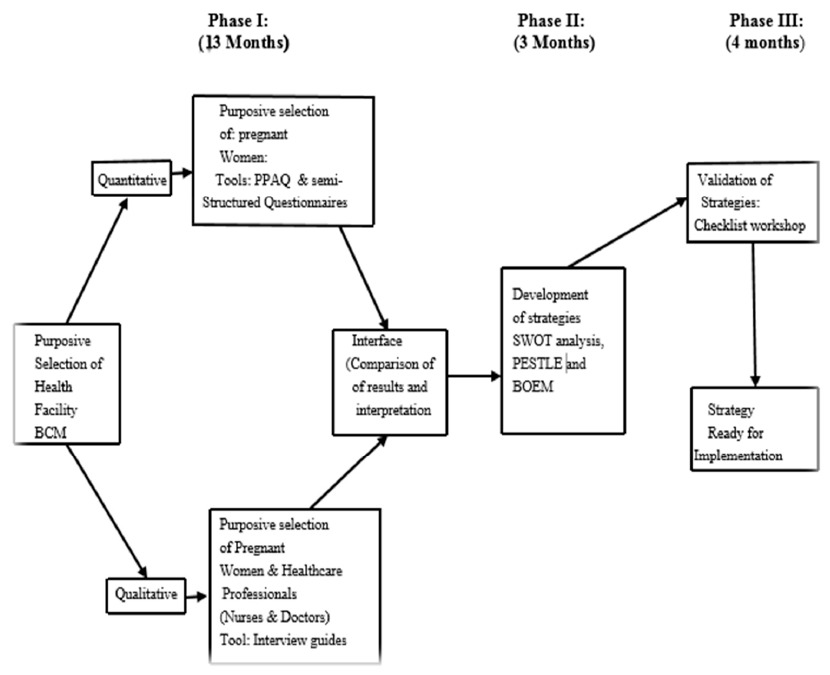
Figure 1. Research approach. BCM = Buffalo City Municipality; PPAQ = Pregnancy Physical Activity Questionnaire; SWOT = Strengths, Weaknesses, Opportunities and Threats; PESTLE = Political, Economic Growth, Socio-Cultural, Technological, Laws and Environmental; BOEM = Build, Overcome, Explore and Minimise .